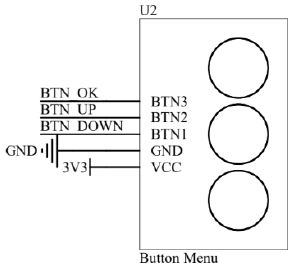
Figure 4 . Buttons in the system.